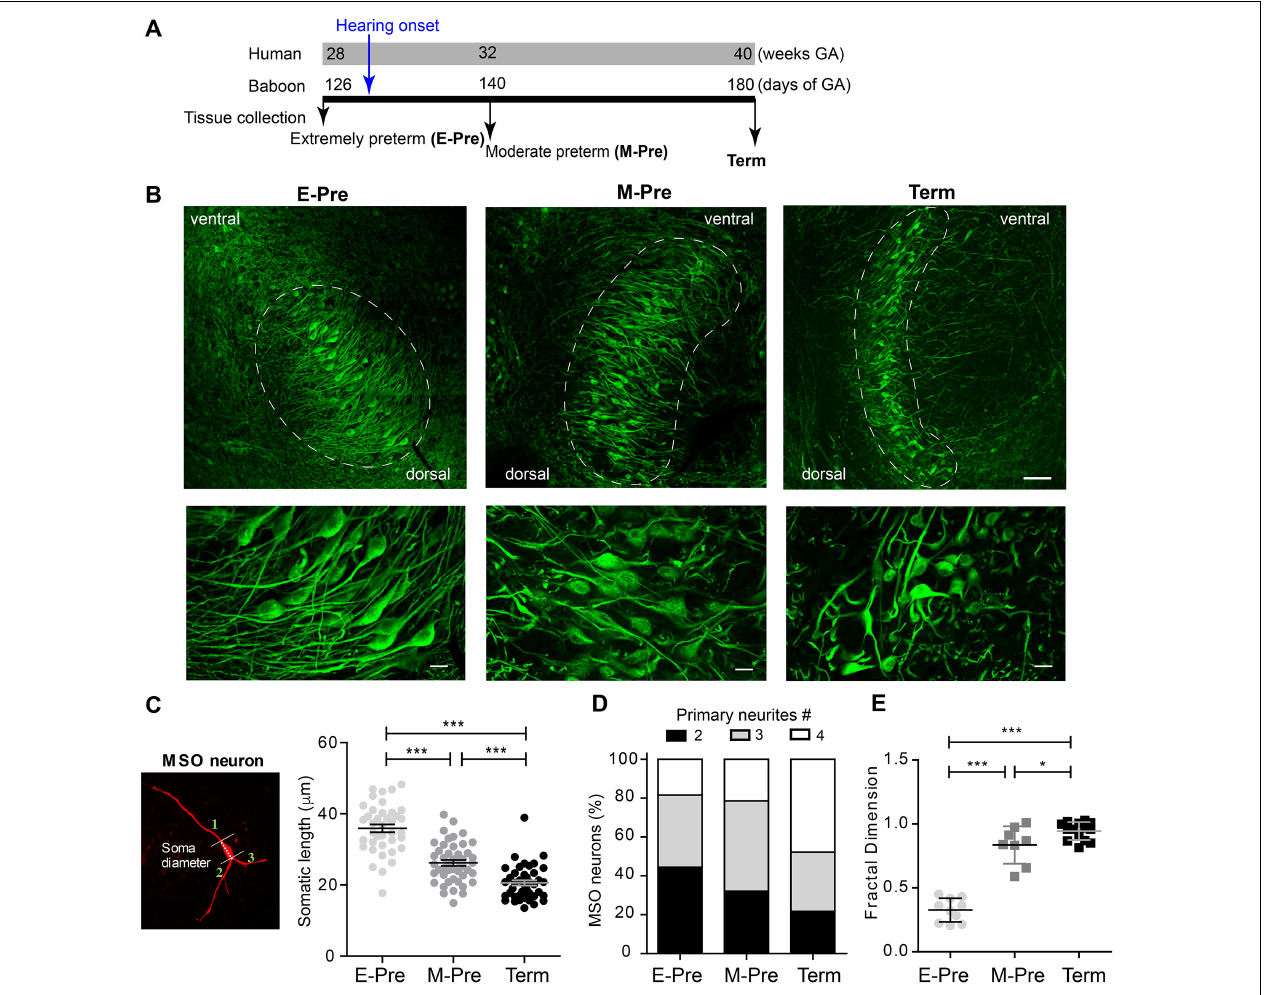
FIGURE 2 | Morphologic changes in MSO neurons during gestational development of baboons in the uterus. (A) Timeline for the last trimester of human (weeks) and baboon (days of gestational age, GA) gestation periods. Hearing onset is around 28 weeks of GA for human fetuses and after 126 days GA for baboons (blue arrow). Auditory brainstem tissues were collected from baboon neonates delivered at 126d GA (E-Pre) and 140d GA (M-Pre) via cesarean section, and full-term (Term) through natural delivery. Black arrows indicate the tissue collection time. (B) MSO neurons were immunostained with MAP2 in the auditory brainstem from E-Pre, M-Pre, and Term neonates. (Top) Circles indicate the MSO area. Scale = 100 µ m. (Bottom) Magnified image of MSO neurons. Scale = 20 µ m. (C) A single MSO neuron from a M-Pre neonate filled by Alexa dye during whole-cell recording. Broken line indicates the somatic length and numbers indicate primary dendrites extending from the soma counted for quantitative analysis. Right: Somatic length from MSO neurons at different GA. (D) Proportions of primary dendrites in MSO neurons at different GA. (E) The fractal dimension, a measure of dendritic complexity, increased throughout the gestational period in E-Pre, M-Pre, and Term neonates. Data were shown as mean ± s.e.m. * < 0.05, ** < 0.01, and *** < 0.001. One-way ANOVA and post hoc Tukey’s multiple comparison